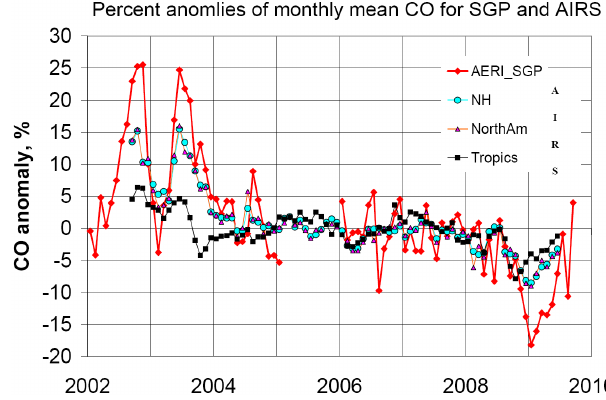
Fig. 12. Mean seasonal cycles for 3 years of simultaneous in situ and remote sensing CO observations at the SGP. Error bars are stan- dard deviations of daily means. For clarity, error bars for the in situ data are only given for 2006.